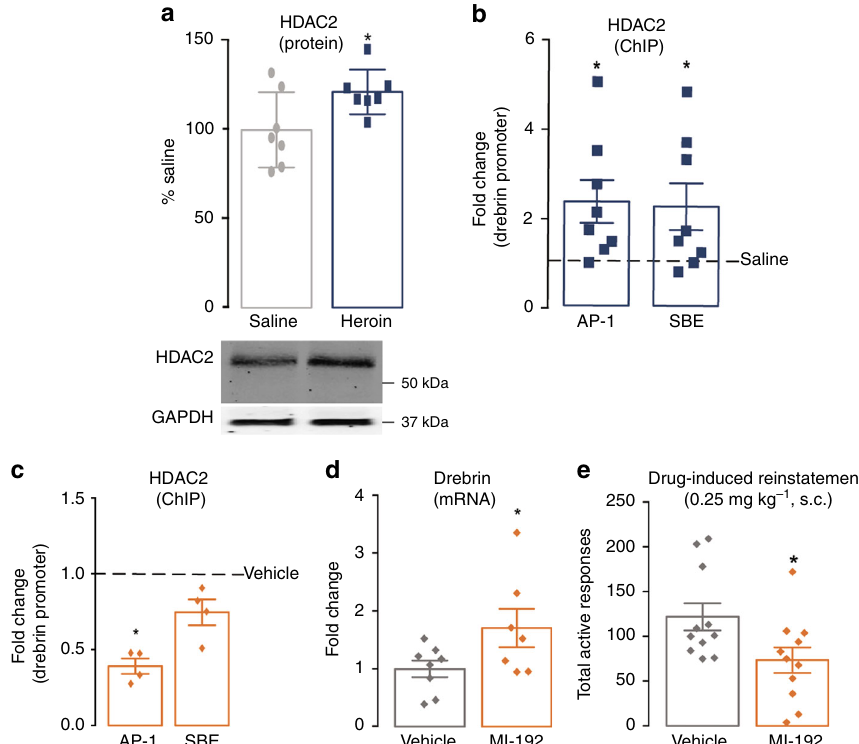
Fig. 2 Epigenetic regulation of drebrin expression following heroin SA. HDAC2 protein expression (Student ’ s t-test: t 12 = 2.279, P < 0.05, n = 7 per group) ( a ) and binding along AP-1 (Student ’ s t -test: t 14 = 2.435, P < 0.05, n = 8 per group) and SBE (Student ’ s t-test: t 14 = 2.17, P < 0.05, n = 8 per group) sites along the drebrin promoter ( b ) following 10 days of heroin SA. HDAC2 binding along AP-1 (Student ’ s t -test: t 6 = 3.383, P < 0.05, n = 4 per group) and SBE (Student ’ s t -test: t 6 = 31.313, P = 0.23, n = 4 per group) sites on the drebrin promoter ( c ), drebrin mRNA levels (Student ’ s t-test: t 13 = 2.056, P < 0.05, n = 7 – 8 per group) ( d ), and total active responses (Student ’ s t -test: t 20 = 2.329, P < 0.05, n = 11 per group) ( e ) following HDAC2 inhibition via